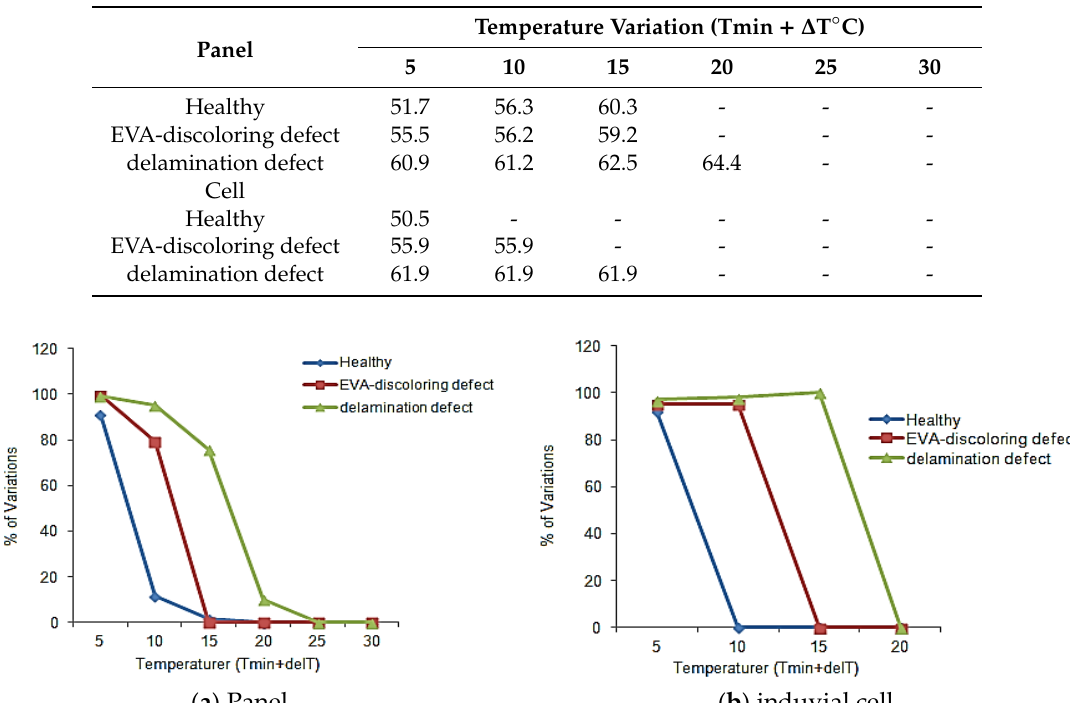
Figure 6. Modified thermal image of the PV panel under ΔT°C=15°C : ( a ) healthy, ( b ) EVA discolouring defect, ( c ) delamination defect.